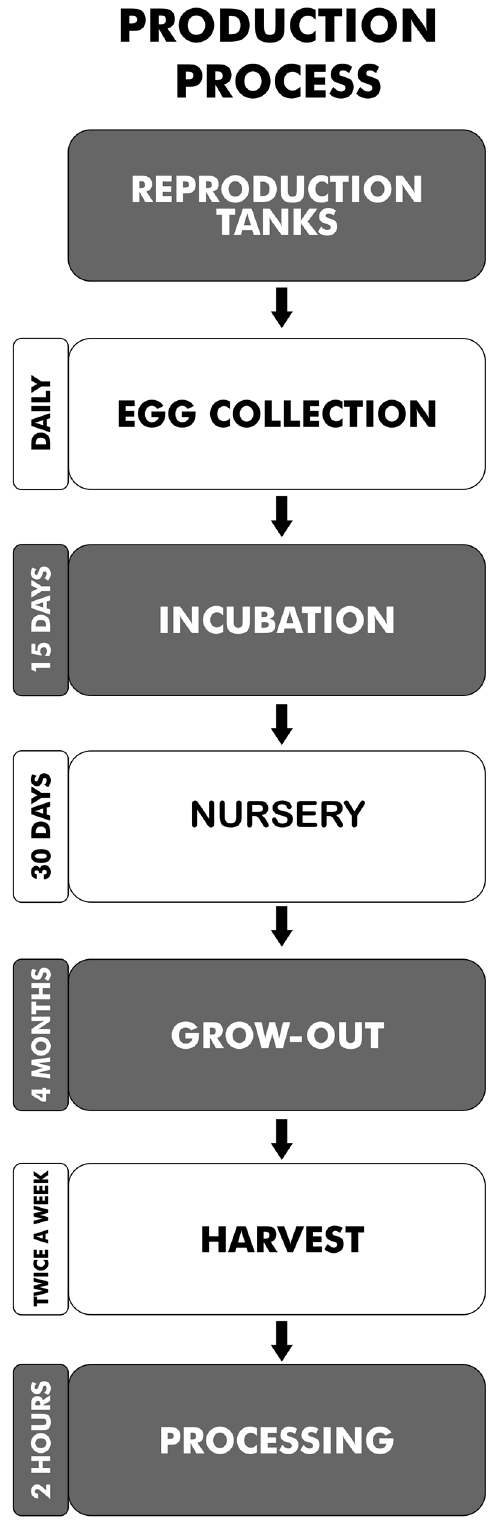
Fig. 2. General production process with time requirements.